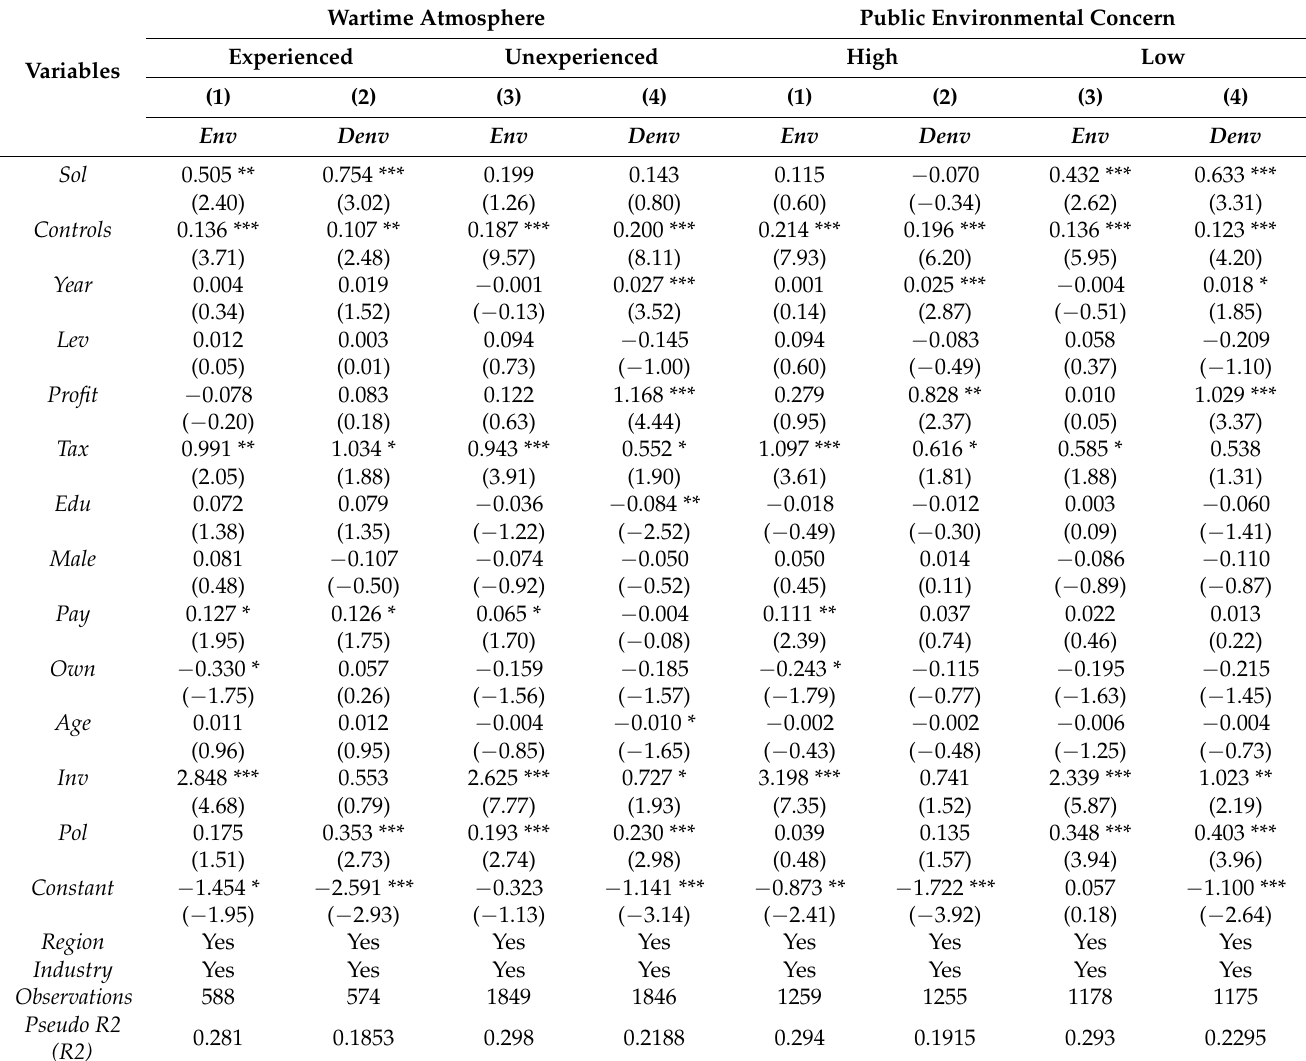
Table 4. The moderating effect of wartime atmosphere and public environmental